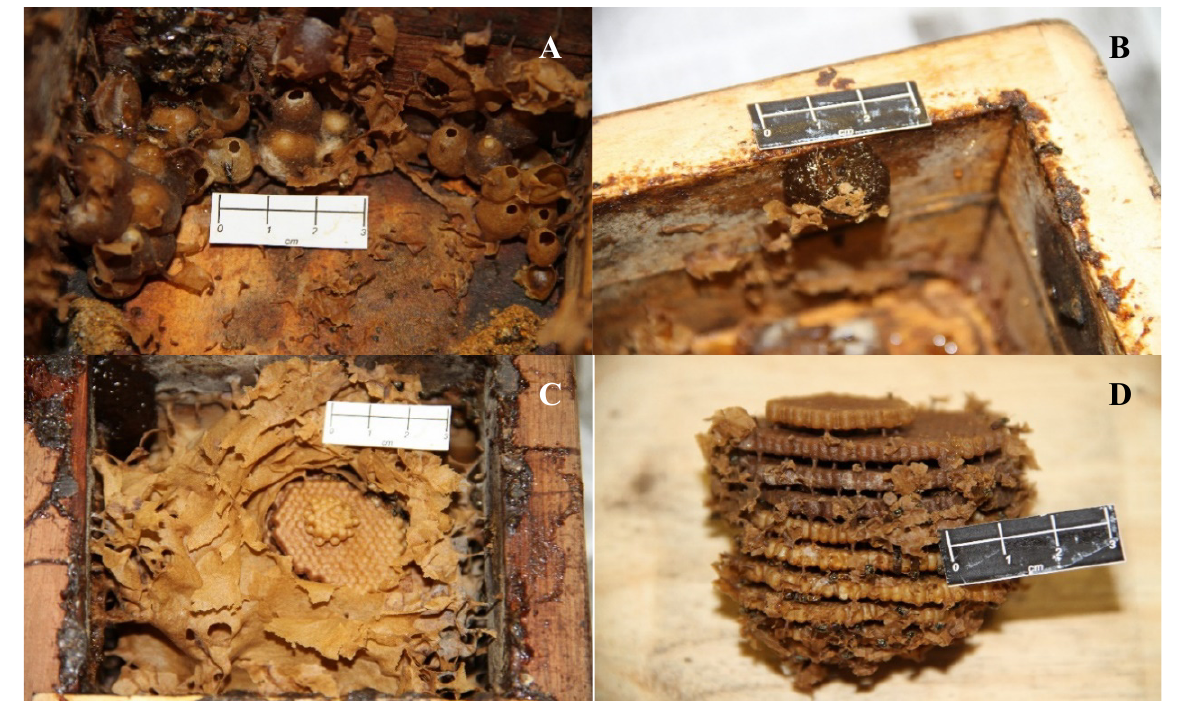
Fig 1. Nest architecture of the stingless bee Plebeia droryana . (A) Food pots (honey and pollen). (B) Resin pile. (C) The nest with all structures. (D) The amount of the combs (brood area). Scale bar 3 mm.